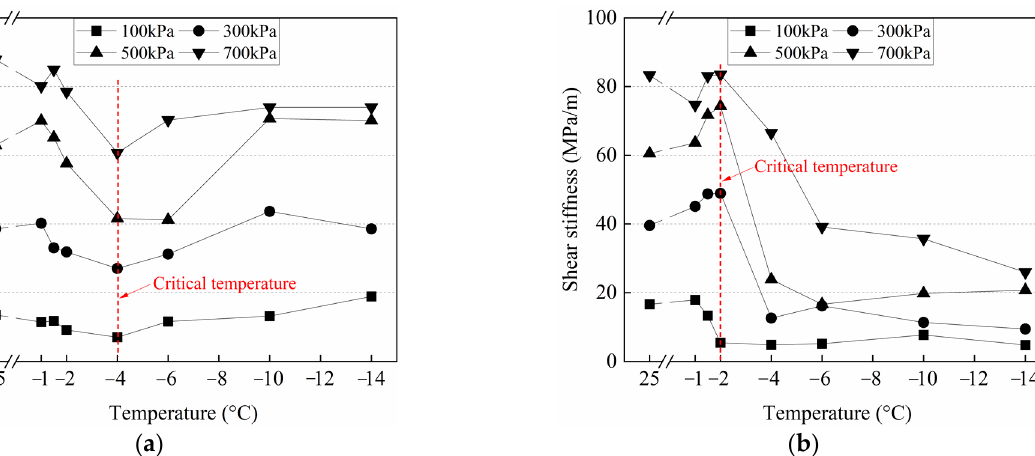
Figure 17. Variation of the shear stiffness with the number of cycles at various normal stresses. ( a ) N = 1; ( b ) N = 30.